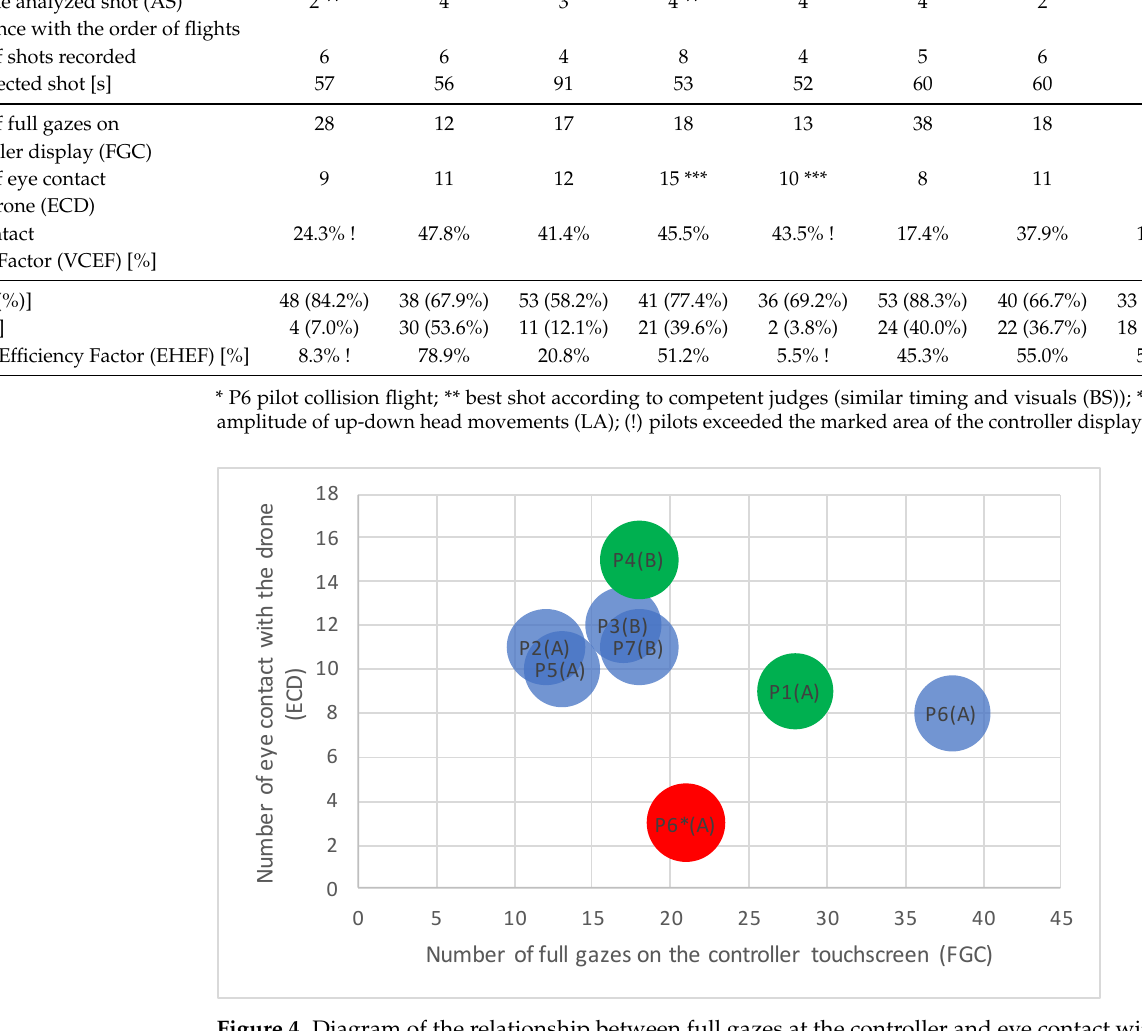
Figure 4. Diagram of the relationship between full gazes at the controller and eye contact with the drone: circle represents a pilot P[X], where A—advanced, B—beginner; Source: own study. Based on the results of the analysis of the best shots from Table 2, it was calculated that the average shot time, in BVLOS, for advanced pilots was 77.4% of the shot time and 67.4% for beginner pilots. It follows that both beginner and advanced pilots did not look at the drone for more than half of the flight time (BVLOS flight time relative to the shooting time is greater than 50%). The minimum flight time with no drone visibility for advanced pilots is 67.9% and for beginner pilots 58.2% of the shooting time. The maximum flight time with no drone visibility is 88.3% for advanced pilots and 77.4% for beginners. The results show that despite the rather narrow air corridor in which the drone could safely maneuver during the VLOS flight, the pilots spent more time observing the image from the drone than the aircraft